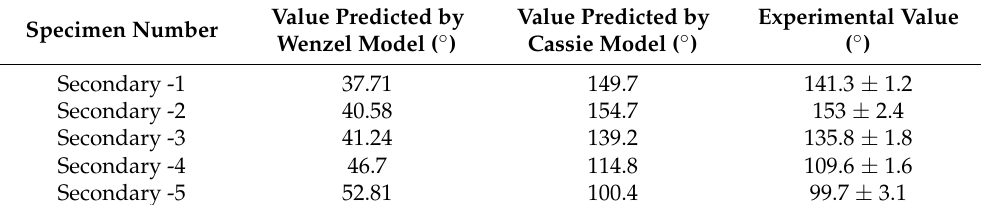
Table 4. Predicted and experimental contact angles of cruciform secondary structures on PMMA surface. Specimen Number